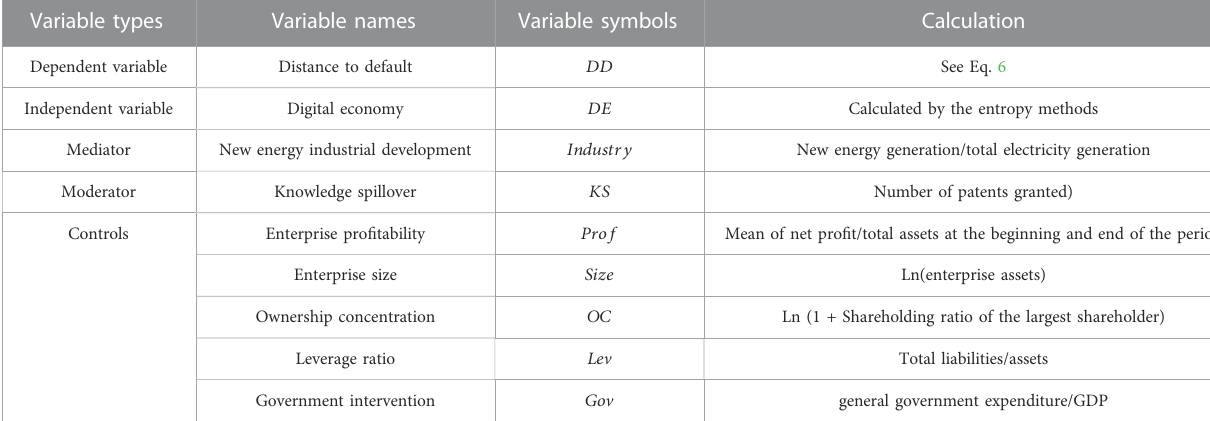
TABLE 2 Variable de fi nitions and